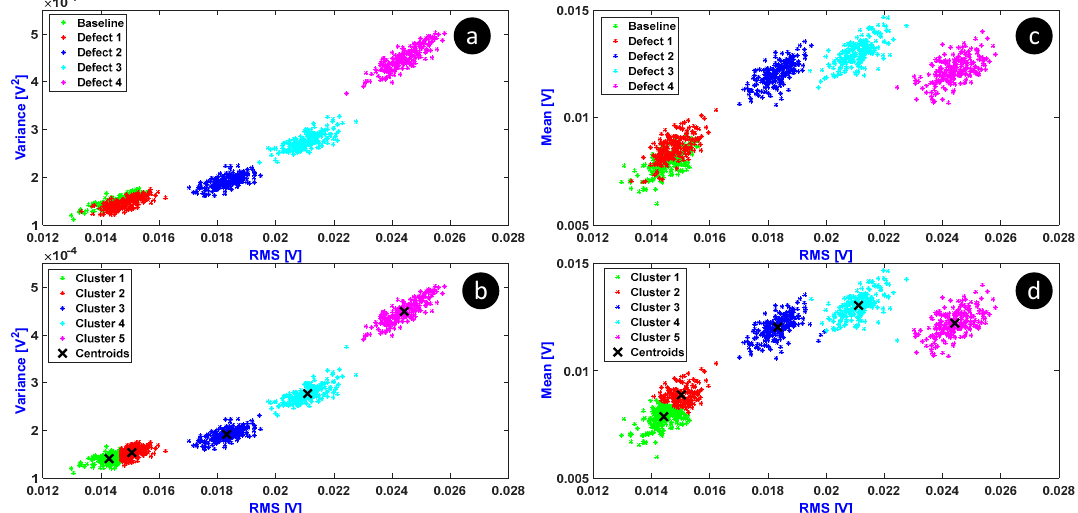
Figure 12. Clustering of collected data using two feature vectors: original clusters for (RMS, variance) ( a ), k-means clusters for (RMS, variance) ( b ), original clusters for (RMS, mean) ( c ), and k-means clusters for (RMS, mean) ( d ).